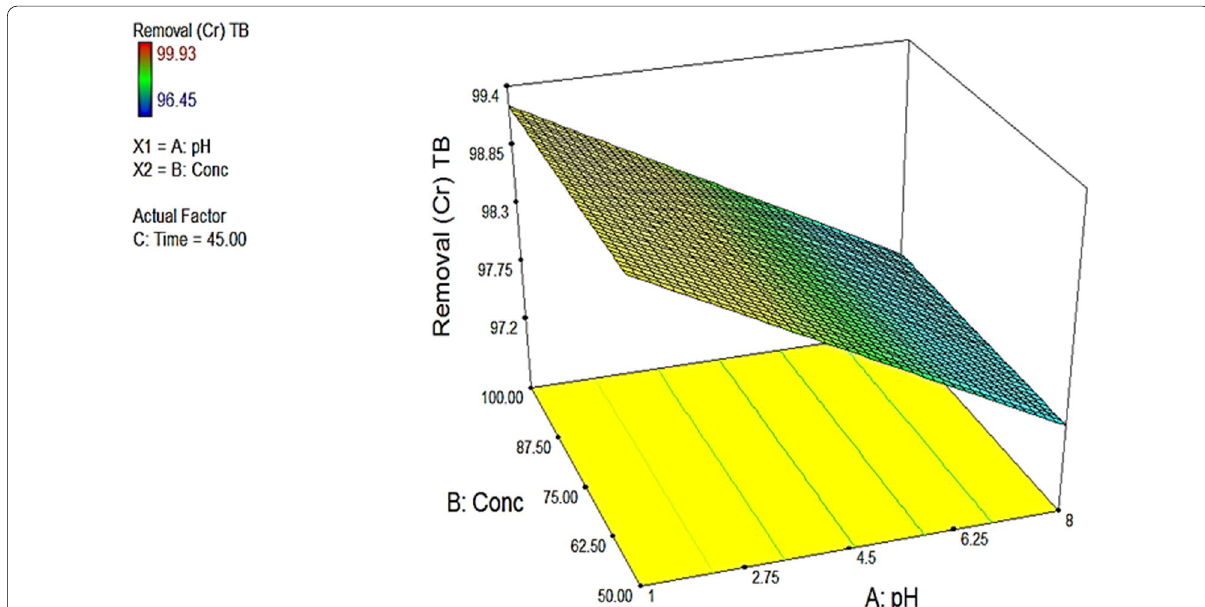
Fig. 6 A 3-dimensional plot of concentration and pH against the percentage removal of chromium when tea bag residues are used as adsorbent